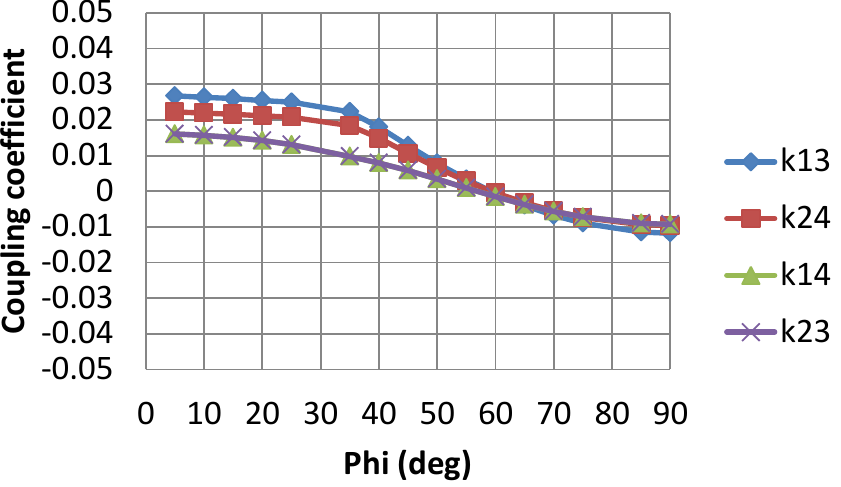
Figure 4. Simulated interference couplings with respect to Φ (Phi).